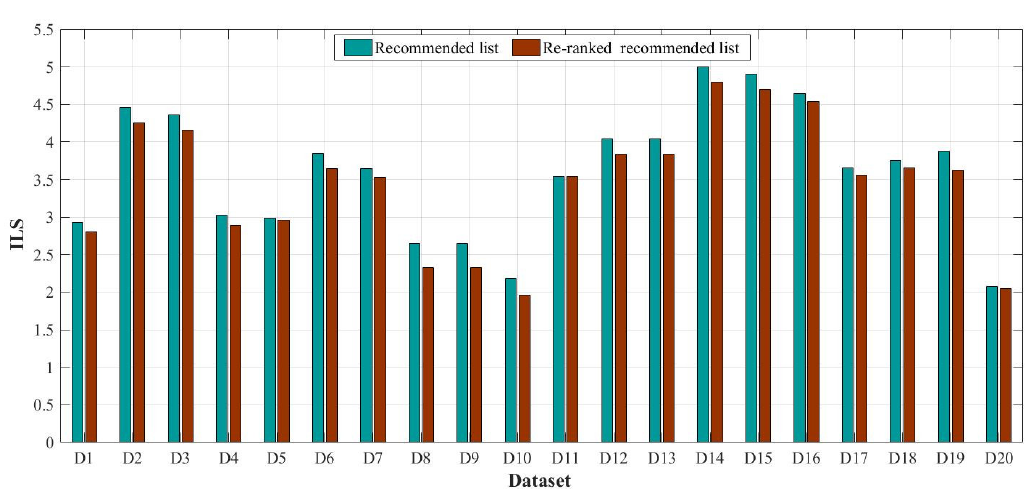
Figure 11. ILS of two recommended lists.